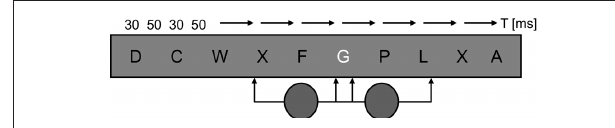
Figure 2 | Time course of a trial. Per trial, ten 30 ms letters appeared singly, separated by 50 ms inter-stimulus intervals, at the center of a local gray background. Only the target letter was white. On half of the trials, a task-irrelevant gray disk was presented for 190 ms. It either preceded the target, so that disk and target offset coincided, or appeared simultaneously with the target, so that disk and target onset